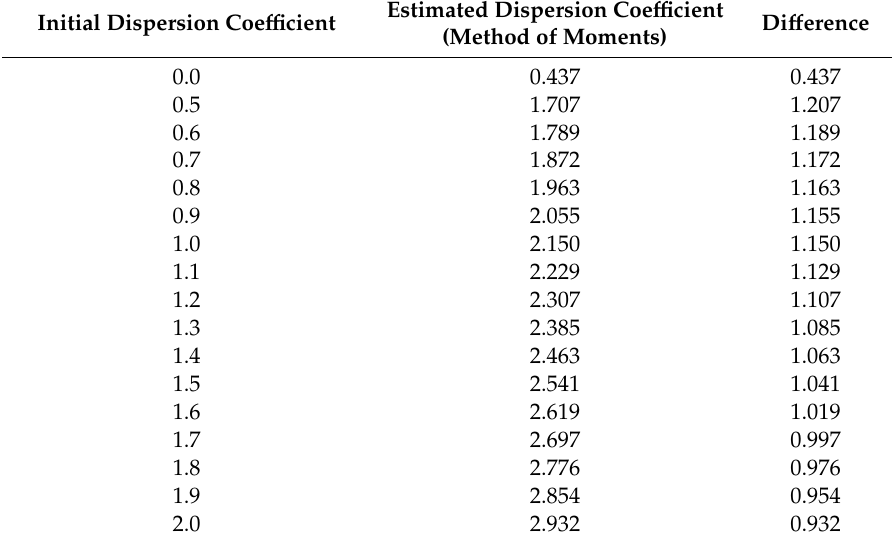
Table 5. 3D model initial and estimated dispersion coe ffi cients based on the method of moments in m 2 /